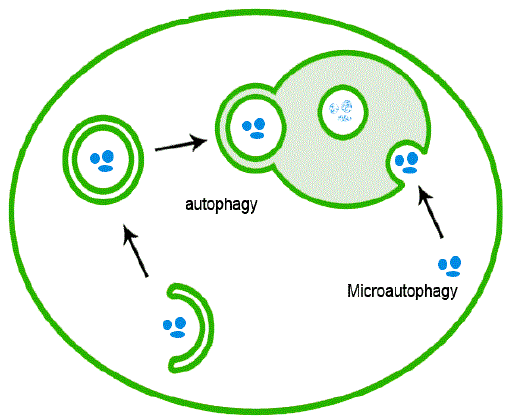
Figure 1. Schematic of autophagy